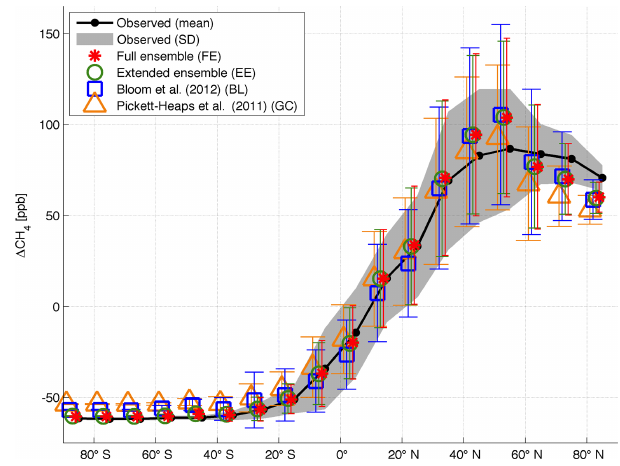
Figure 8. Mean 2009–2010 CH 4 measurements and model CH 4 zonal anomalies ( (cid:49) CH 4 ) relative to the mean 2009–2010 global CH 4 concentration. The black dots denote the mean WDCGG net- work observed CH 4 concentrations within 5 ◦ latitude bins; the grey envelope denotes the mean 2009–2010 standard deviation across all sites within 5 ◦ latitude bins. The coloured symbols and error bars denote the GEOS-Chem equivalent model concentration statistics based on the FE and EE ensembles (this study), Bloom et al. (2012) (BL) and the GEOS-Chem emissions inventory (GC) wetland CH 4 emission